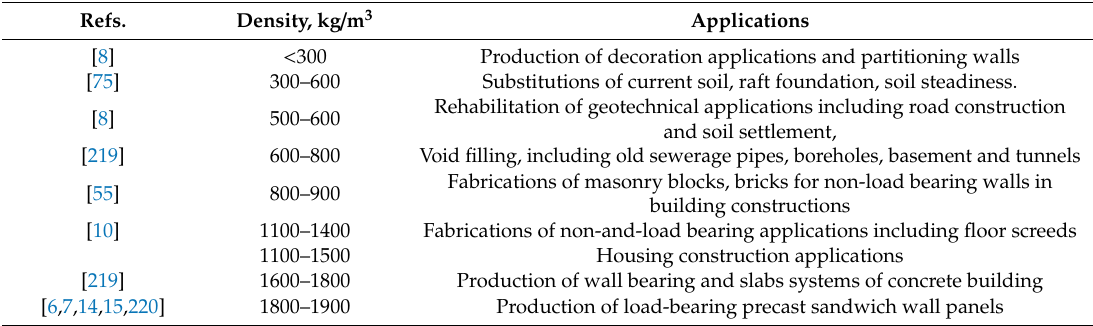
Figure 8. Application of FRFC. Table 9. Applications of